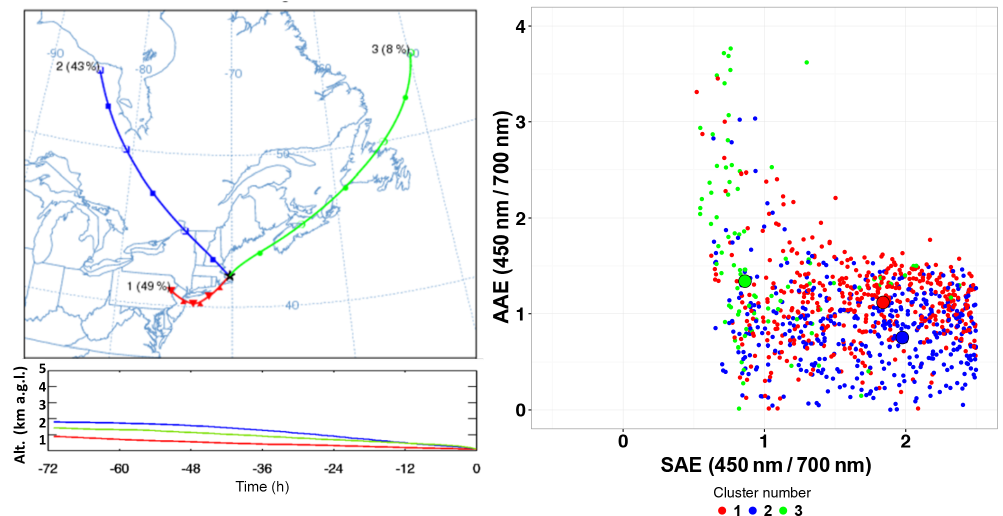
Figure 6. Back trajectory map, back trajectory height (in kilometers above ground level) vs. time and AAE vs. SAE plot space for Cape Cod, Massachusetts, USA, station PVC, all color-coded by back trajectory cluster